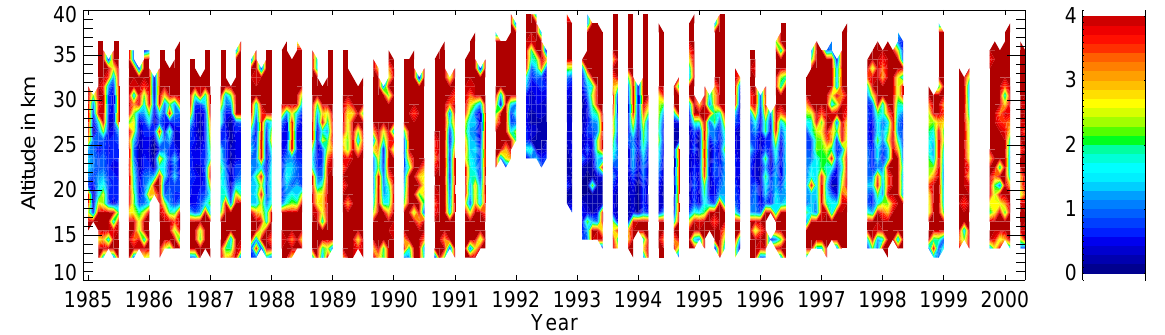
Fig. 2. Temporal and vertical evolution of the relative uncertainty on the particle number density illustrated in Fig. 1.